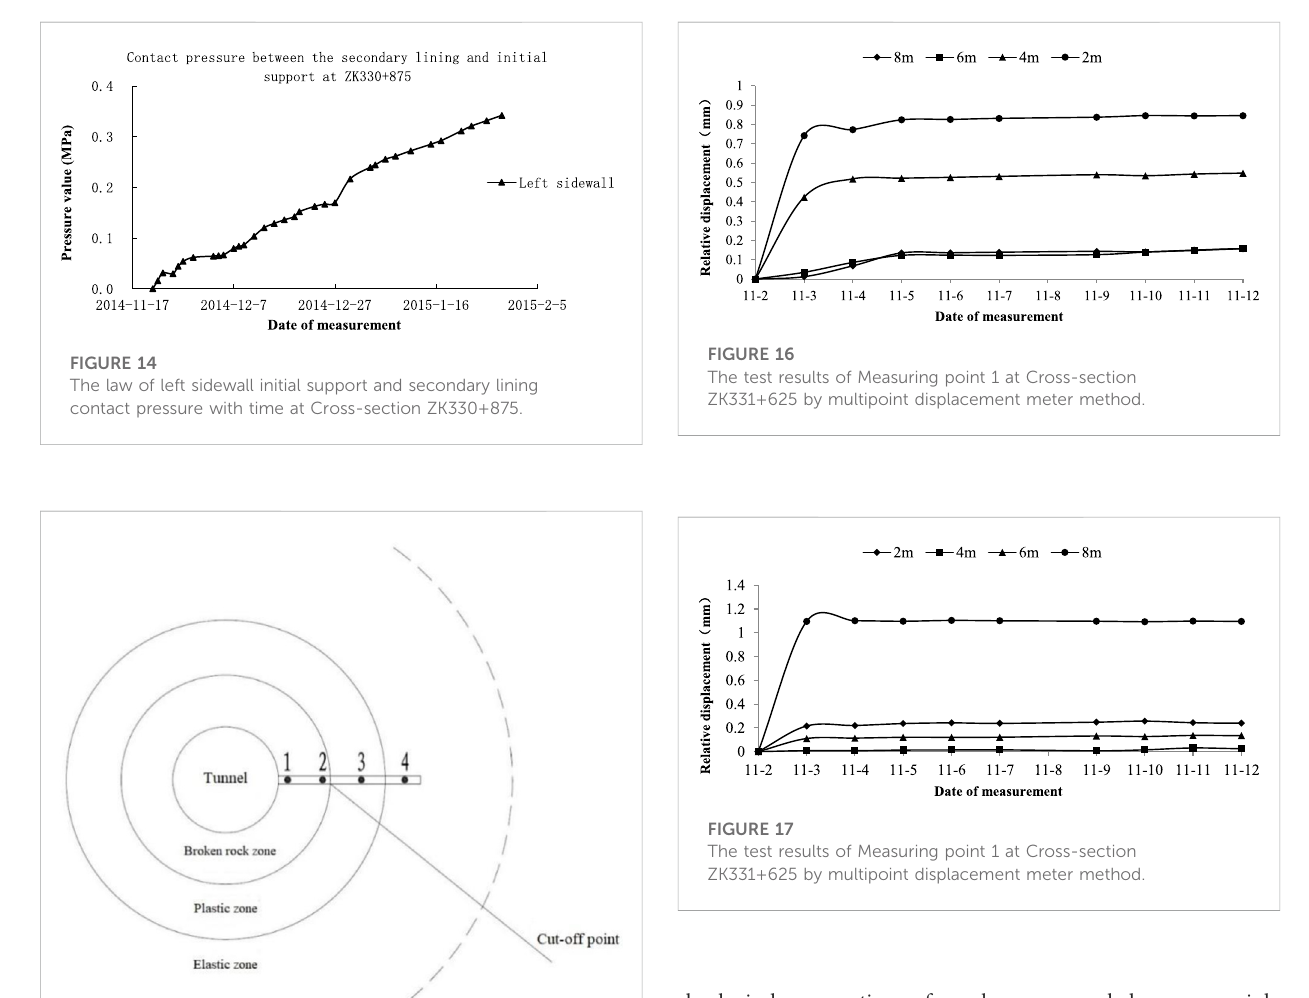
FIGURE 15 Testing principle of multipoint displacement meter method.